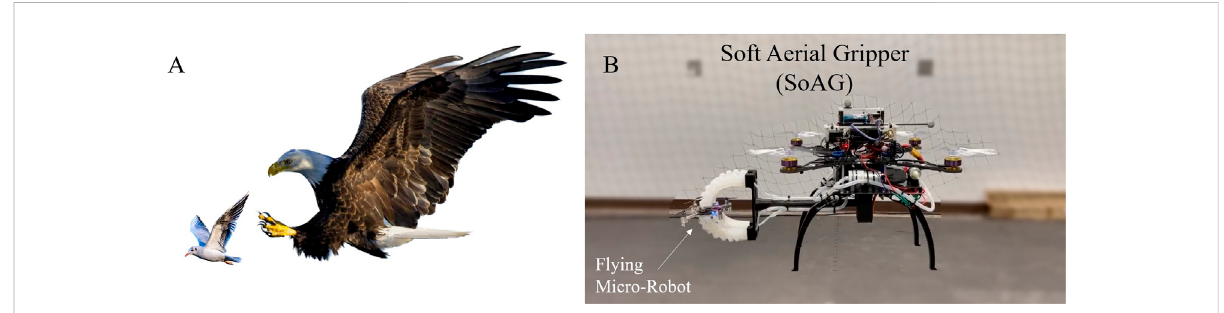
FIGURE 1 Bio-inspiration and prototype of the project. (A) An eagle is horizontally catching a small bird in mid-air. (B) To enable horizontal grasping, we developanopen-sourcemicro-aerialvehicle(MAV)equippedwithasoftend-effectorandonboardpneumaticregulationnamedSoftAerial Gripper (SoAG).